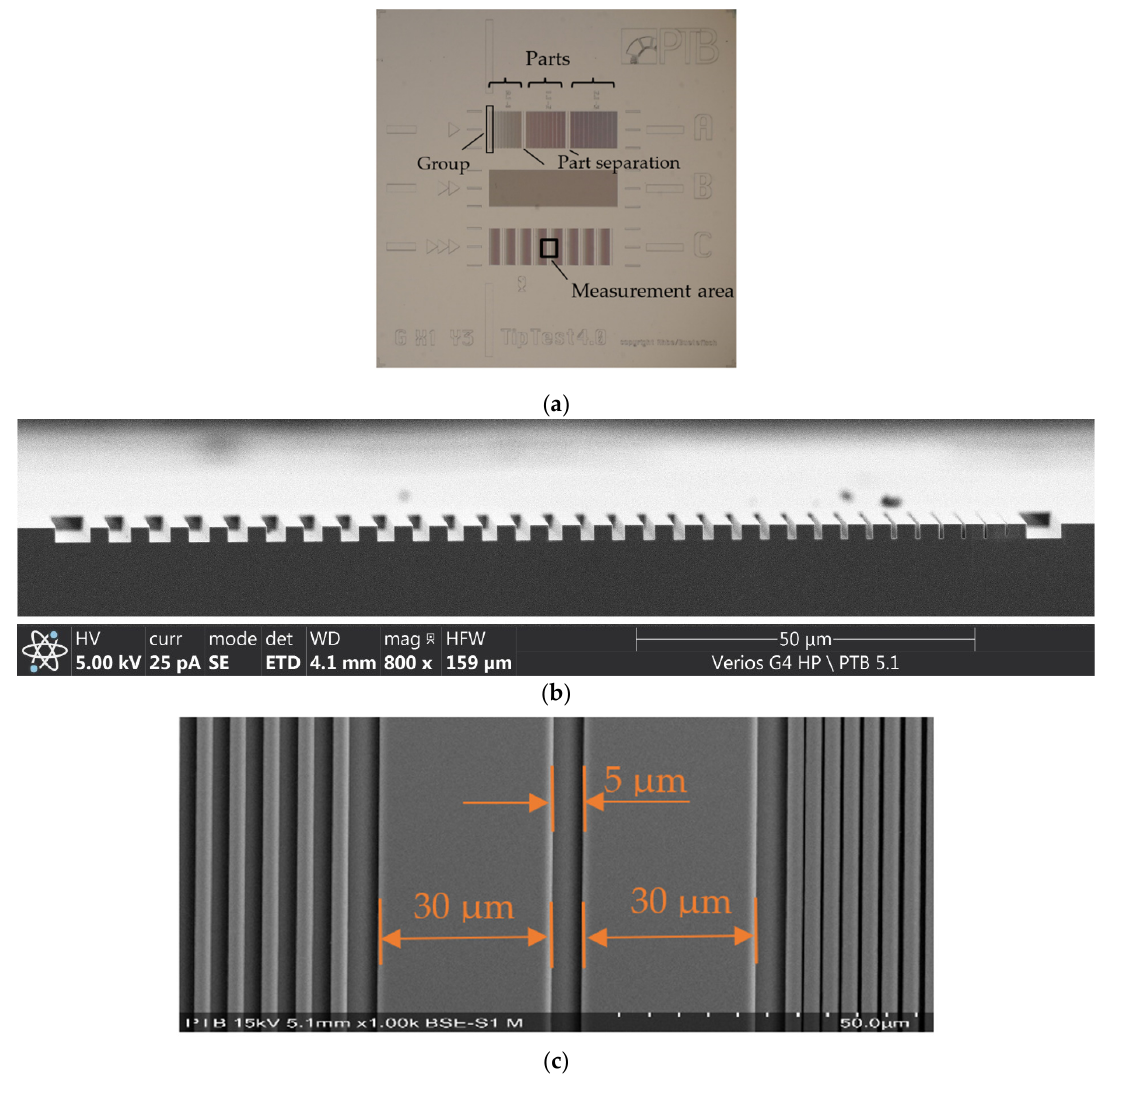
Figure 7. The TSPN tip characterizer used. ( a ) Three row structures, and the measurement area in the experiments; ( b ) cross section of row C, the groove widths from 0.1 µm to 3 µm; and ( c ) part separation structure of row C.